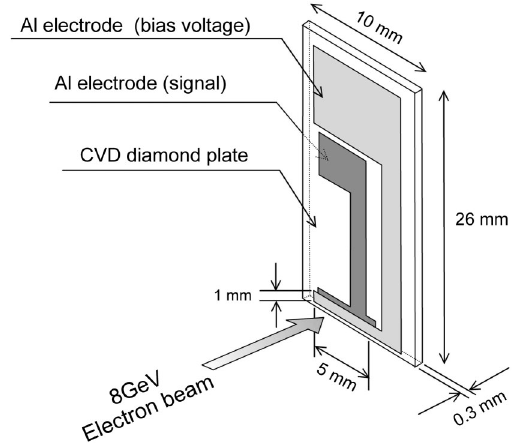
FIG. 2. Structure of the diamond-based detector.